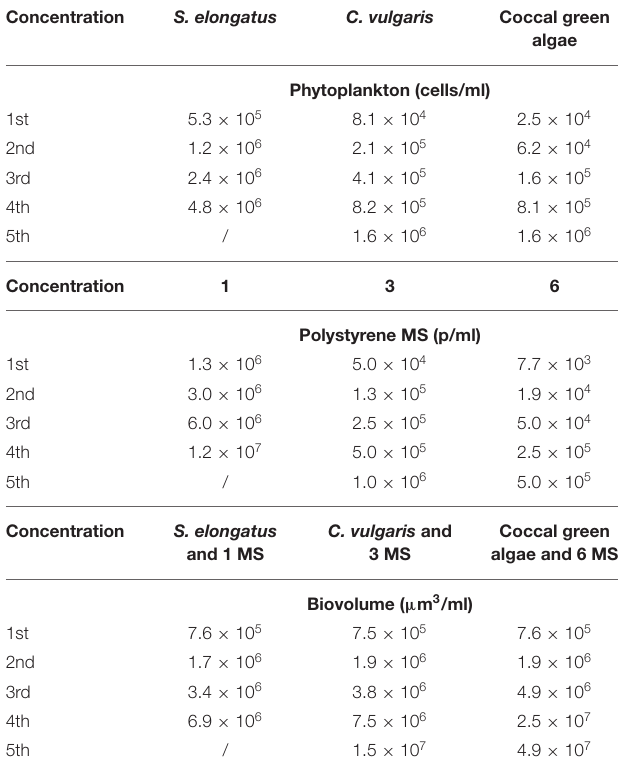
TABLE 2 | Concentration and (bio) volume of phytoplankton ( Synechococcus elongatus , Chlorella vulgaris, and coccal green algae) and polystyrene MS (1, 3, and 6 µ m) used in the aggregation and ingestion